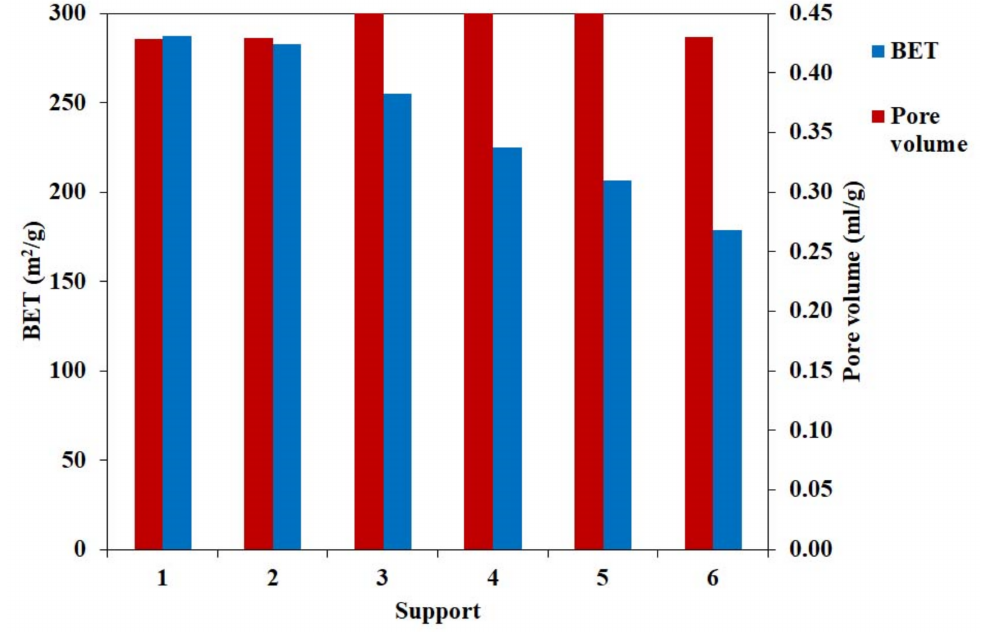
Figure 8. Specific surface area and pore volume of supports 1–6.